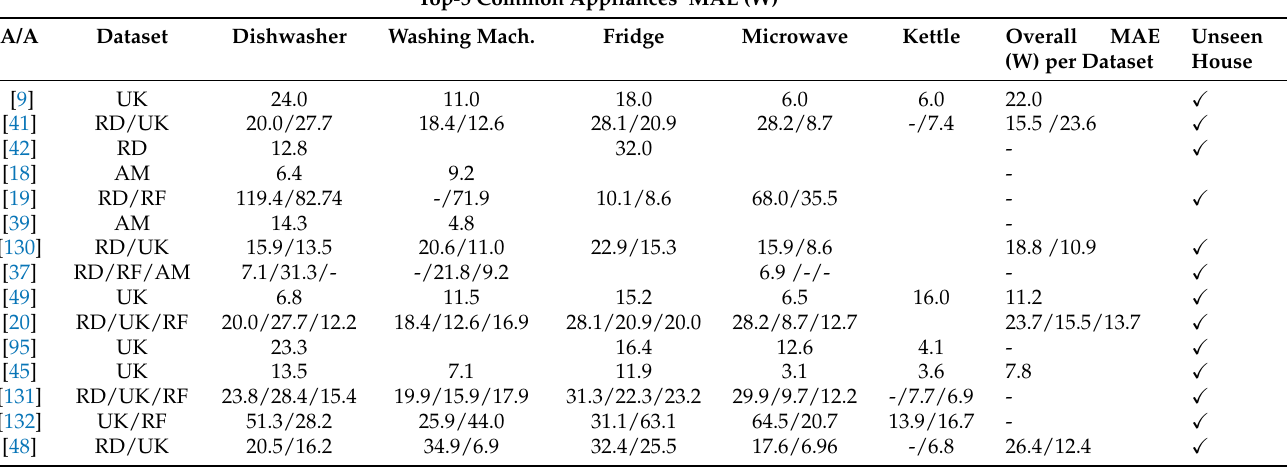
Table 3. NILM researchfrom a practical perspective. Datasets utilized, performance achieved per appliance, and adaptability of the NILM algorithms. In cases where the unseen house option is checked, the performance in the table refers to unseen houses of the same dataset that are used only for training (RD:REDD, RF:REFIT, AM:AMPds, UK:UK-DALE). Top-5 Common Appliances’ MAE